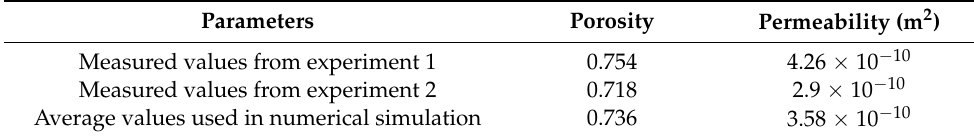
Table 2. Parameters of material property of the seven-layer fiber